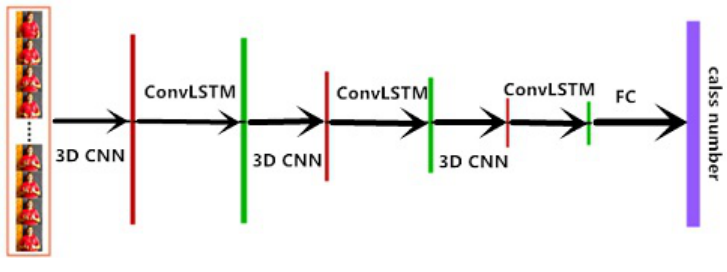
Figure 1. The network proposed in Figure 1. The frame set of video needs to go through three consecutive 3D CNN operations and ConvLSTM operations, and then we can get feature maps with a large amount of space-time information. Finally, feature maps are fully connected to the corresponding classification results. Each vertical line in the figure represents the state of the feature map set after a 3D CNN operation or ConvLSTM operation. The parameter transformation of each layer of the feature map is shown in Figure